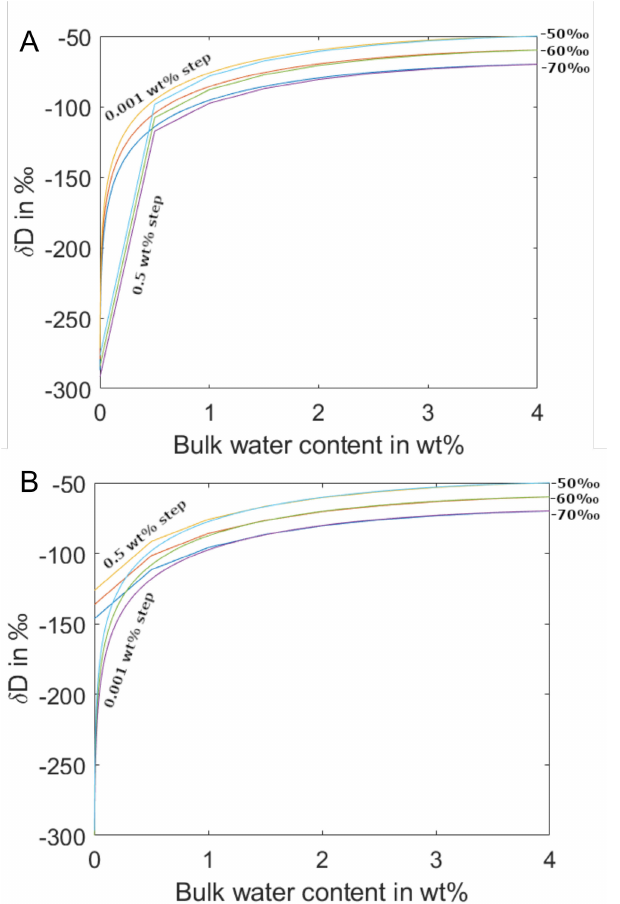
Figure 5: Graphs displaying VolcDeGas models having fixed 0.001 wt.% and 0.5 wt.% H an [A] open system and [B] batched system. The ini- tial values are: 4 wt.% bulk H ´ 50 % (cid:24) δ D. It is clear that having a small step size in ei-